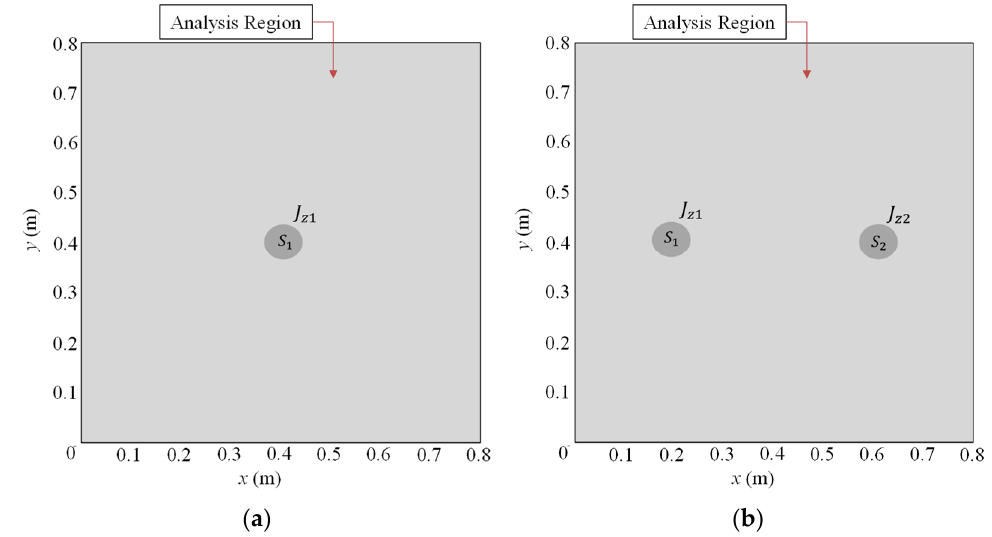
Figure 2. The illustrative quasi-magnetostatic problems: ( a ) single conductor; ( b ) two parallel conductors.